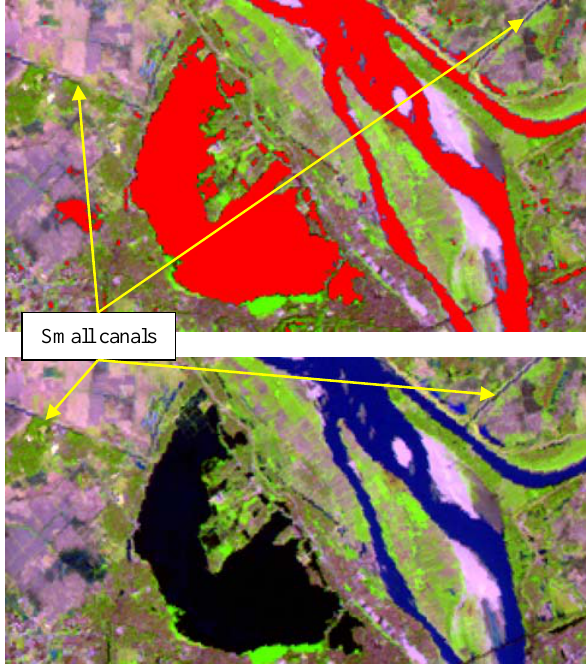
Figure 9. Water body extraction for Landsat 5 TM (top),) and in colour composite (bottom)